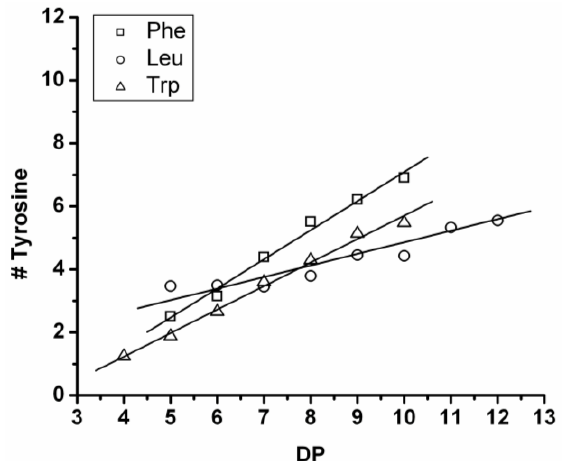
Figure 17. Average number of tyrosine residues in co-oligomers with Phe, Leu or